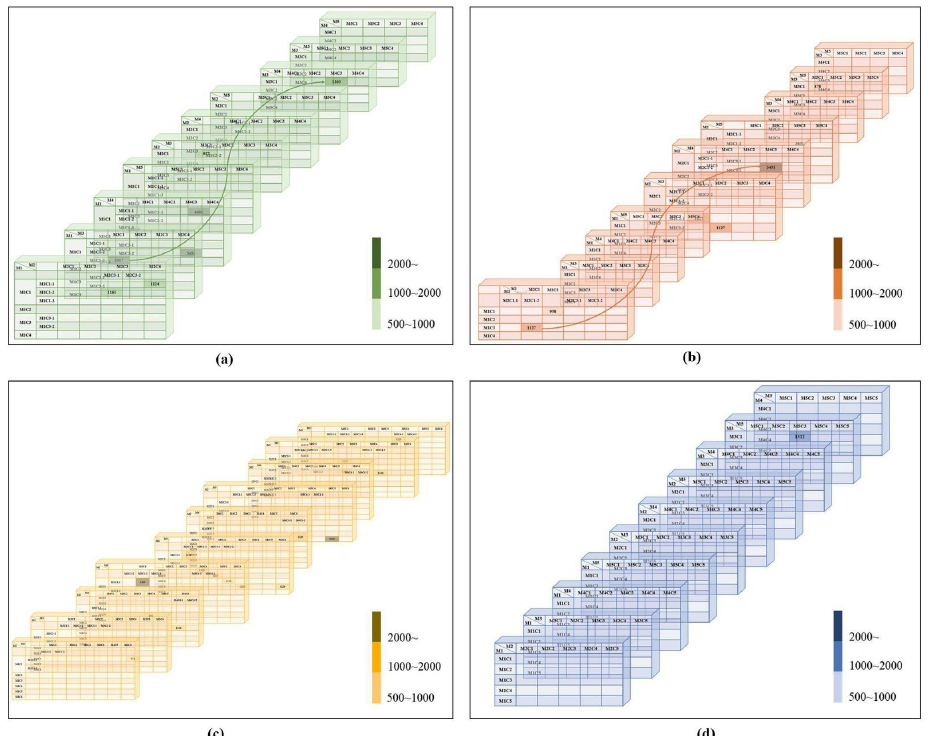
Figure 2. Anticlinal wall result – straight results. ( a ) four-grayscale clusters result, ( b ) four-threshold clusters result, ( c ) six-grayscale clusters result, ( d ) five-colored clusters result. Figure 2b shows that the numerical value for identical M2C3-1 and M3C1 and M2C3- 2 and M3C2 ranges from 1120 to 1127. Moreover, the numerical value for identical models, M2C1 and M2C1-1, M2C2 and M3C1-2, M2C3 and M2C1-1, M2C4 and M3C2-2, M2C5 and M3C3, M2C5 and M3C6, M4C1 and M5C4-1, M4C5 and M5C1-2, M4C6 and M5C1- 2′ s in Figure 2c ranges from 1120 to 1127. Therefore, these images can be considered identical. However, there is no relationship in Figure 2c, d. In Figure 2d, only a relation of 1312 is shown. Related M2C3 and M3C3 in one thread that corresponds to M3C1 and M2C3 in Fig- ure 3c. In both groups Figure 3a, b, there is no connection and no thread.